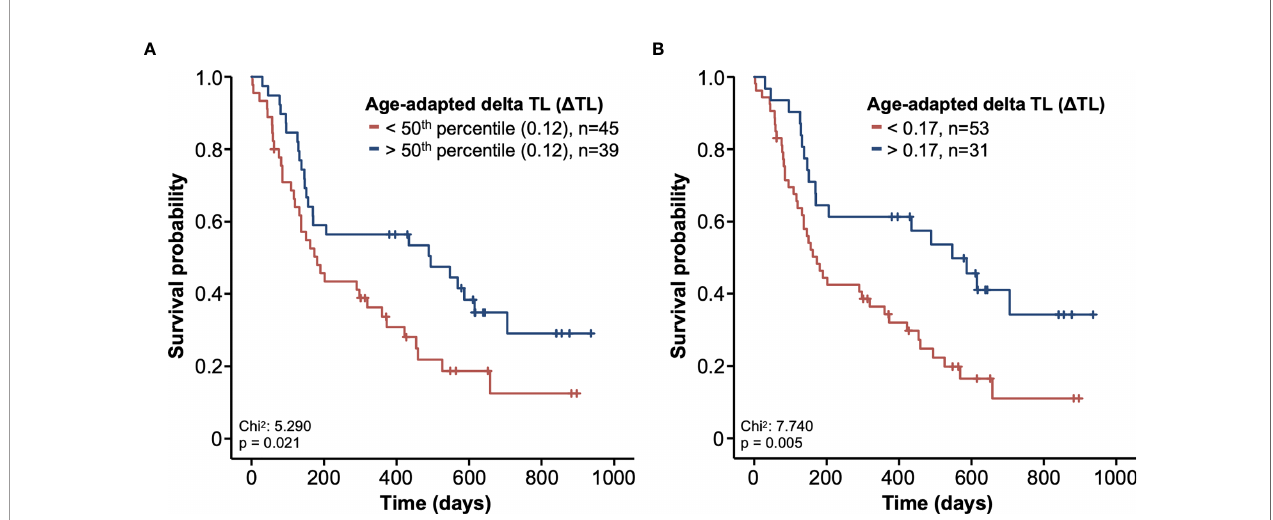
FIGURE 3 | Kaplan-Meier curves of survival. The survival probability is shown in relation to the course of time. Patients were divided into two groups based on the D TL. (A) In the fi rst graphic, the group was split based on the 50 th percentile. (B) In the second graphic, a relative telomere length of 0.17 was used as a cut-off. Patients with longer telomeres are shown in blue and patients with shorter telomeres are shown in